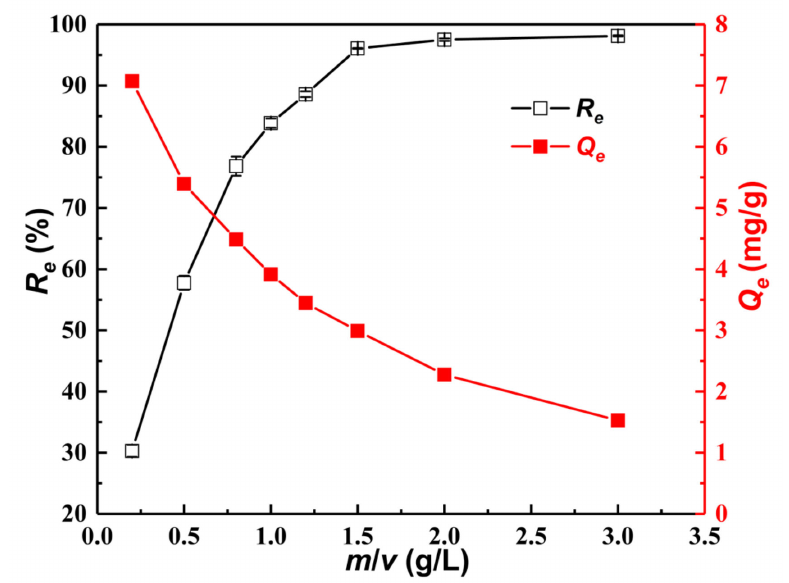
Figure 9. Changes in As(III) adsorption capacities ( Q e ) and removal efficiency ( R e ) with the m/v